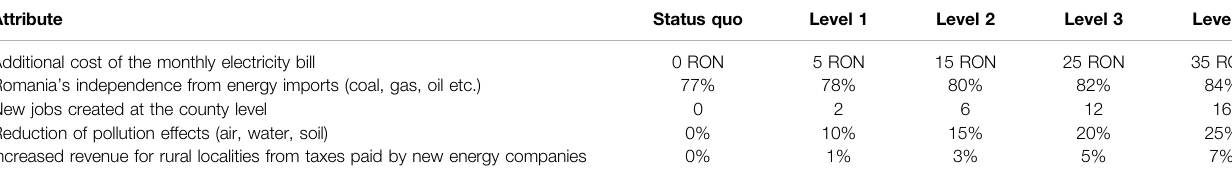
TABLE 1 | Summary of the attributes and levels included in the discrete choice experiment.